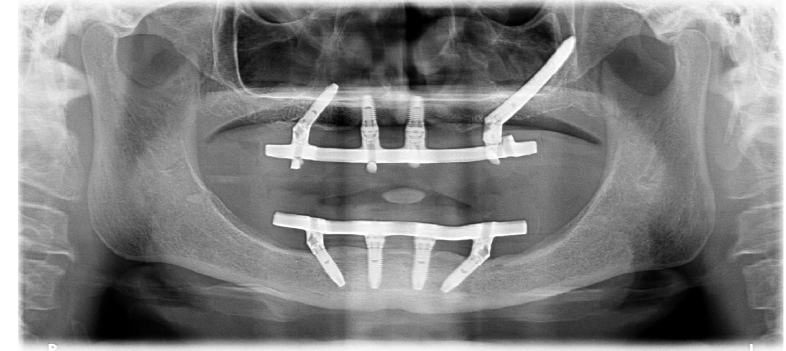
Figure 31. Orthopantomography with the definitive prosthesis connected one year after the Figure31. intervention.